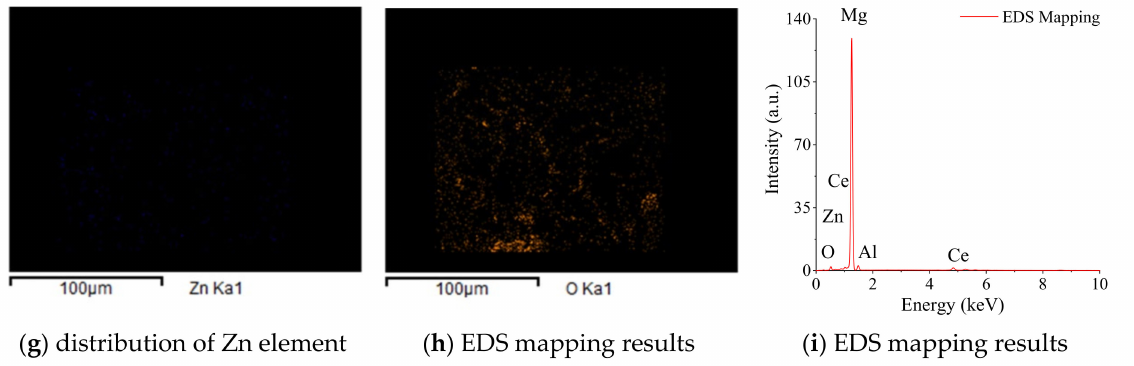
Figure 7. Morphology of the sample with 3 wt.% Ce added.